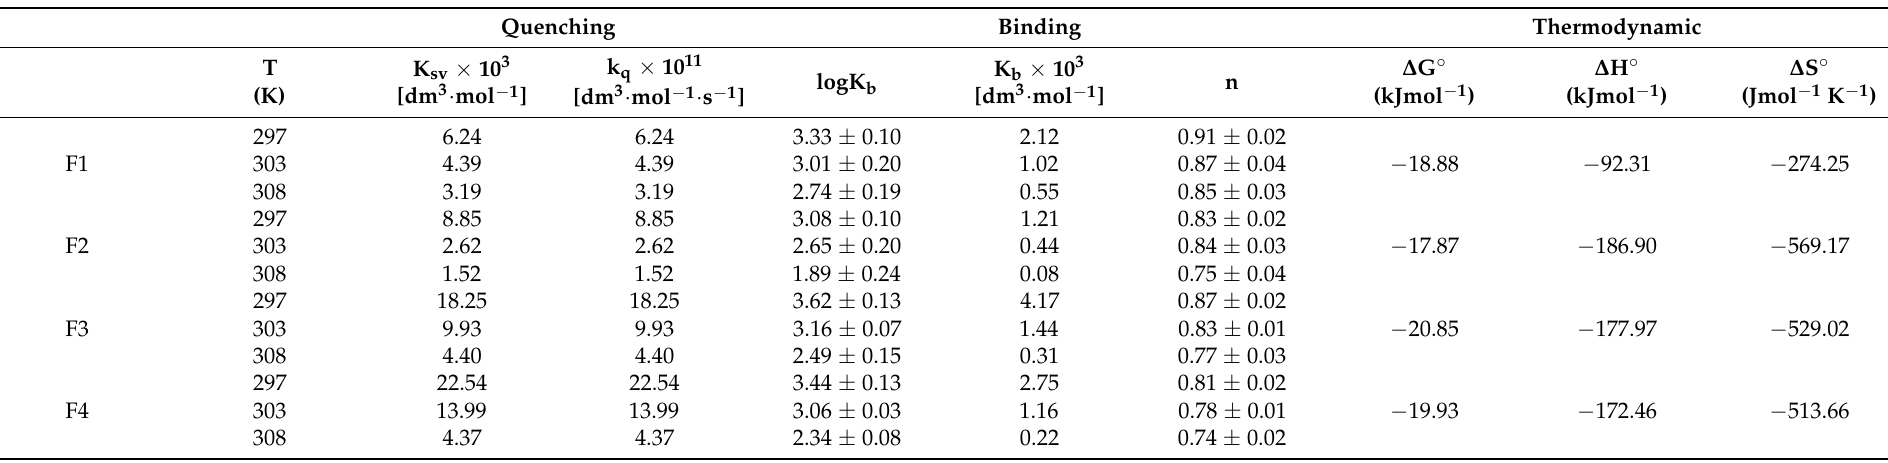
Table 2. The Stern–Volmer constant, K sv , quenching rate constant, k q , binding constant, K b , number of binding sites, n, and thermodynamic parameters for the interaction of AAG with the studied compounds at different